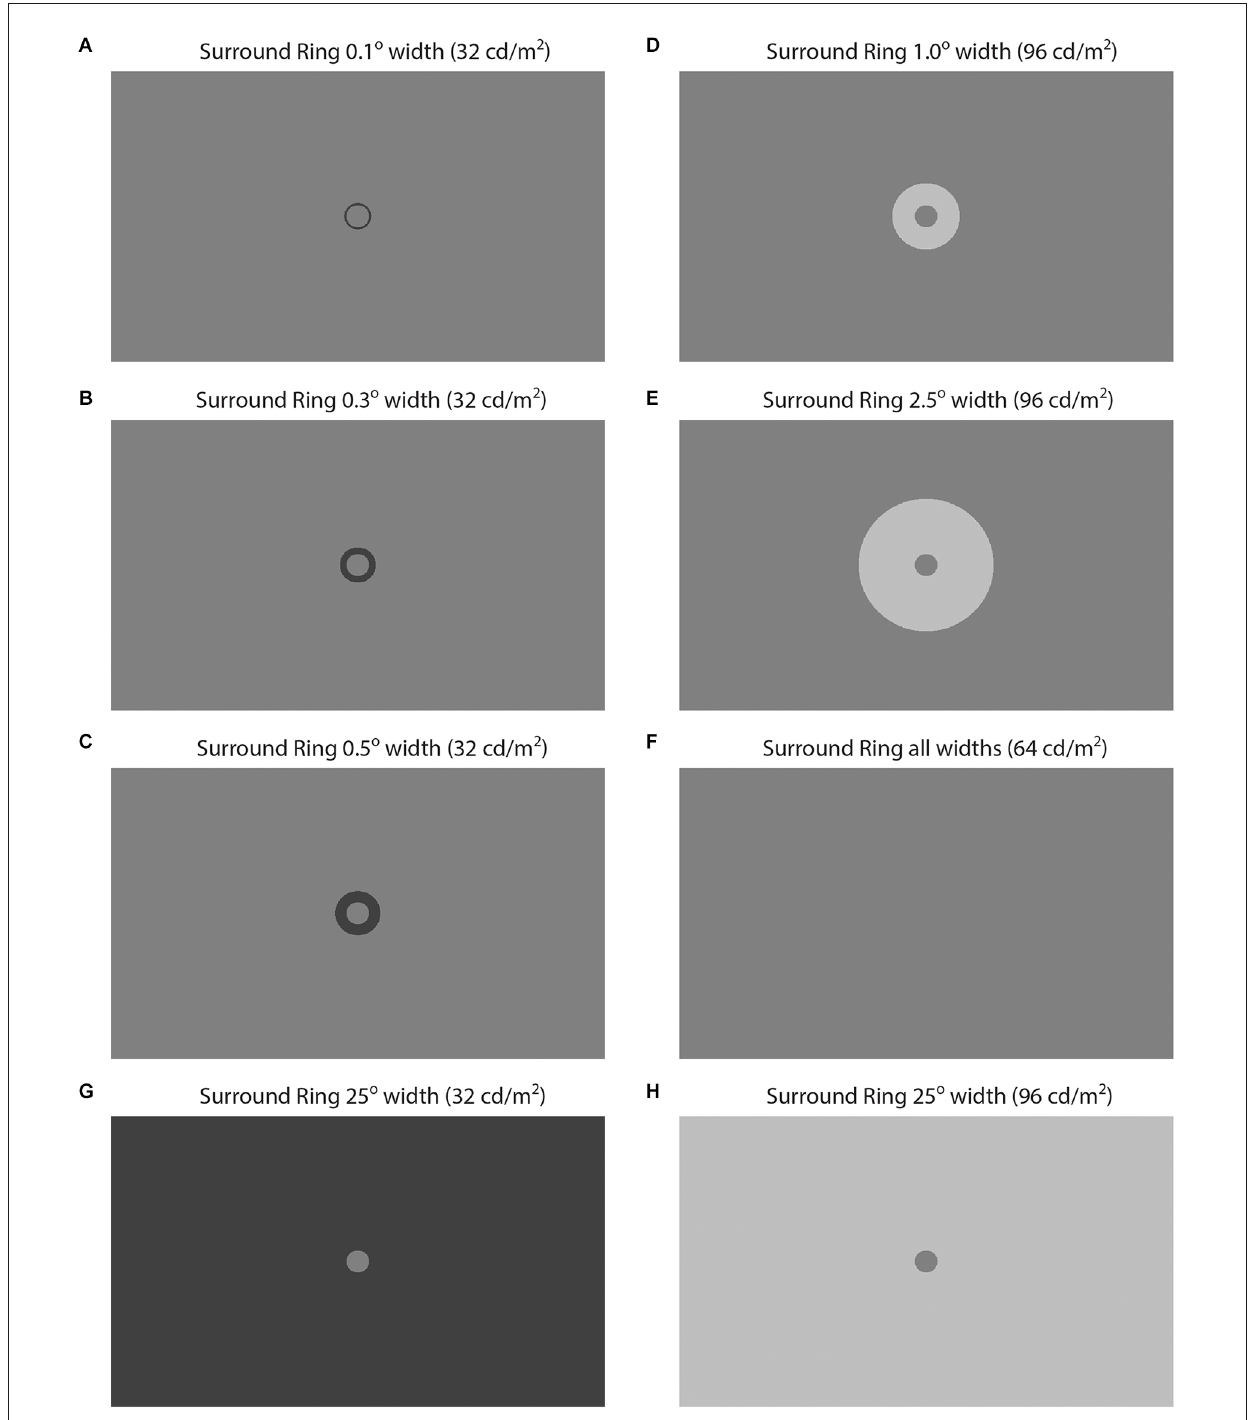
FIGURE1 IllustrationofsomeofthebrightnessinductionstimulifromExperiment1.In (A–H) circulartargetpatchluminanceis64cd/m 2 andtargetpatchradius is 0.5 ◦ . In (A–F) the remote background is 64 cd/m 2 and the adjacent surround-ring varies in luminance and width. In (A–C) adjacent surround-ring luminance is 32 cd/m 2 and adjacent surround-ring width is (A) 0.1 ◦ , (B) 0.3 ◦ , and (C) 0.5 ◦ . In (D,E) adjacent surround-ring luminance is 96 cd/m 2 and adjacent surround-ring width is (D) 1.0 ◦ and (E) 2.5 ◦ . In (F) adjacent surround-ring luminance is 64 cd/m 2 . Since the target patch and remote background luminance are also 64 cd/m 2 this stimulus reduces to homogeneous field for all adjacent surround-ring widths. In (G,H) adjacent surround-ring width is expanded to 25 ◦ such that there is no remote background. In (G) the luminance of the adjacent surround-ring is 32 cd/m 2 and in (H) it is 96 cd/m 2 .